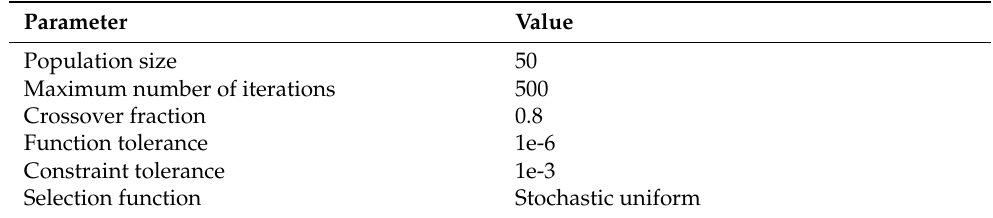
Table 3. GA parameters used in the case study.